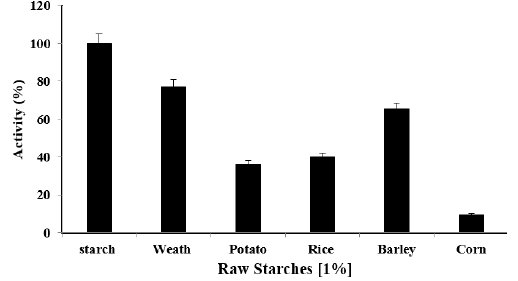
Fig. 5. The digestibility of UMF29 alpha-amylase for 1% (w/v) concentration of various raw starches after 5 h of incubation. During direct